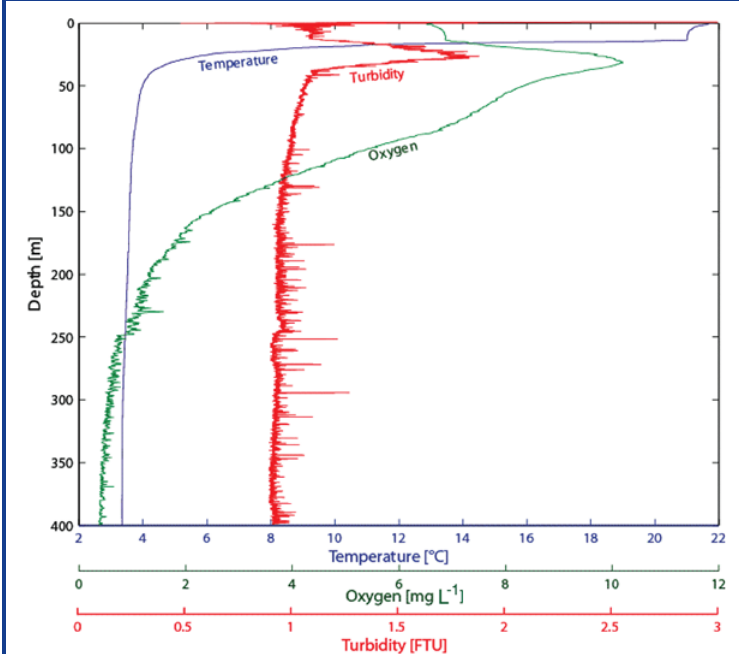
Figure 5. Temperature, turbidity (Formazin Turbidity Units), and oxygen profiles acquired with a CTD probe at the Tatvan Basin mooring site on 28 August 2009 (from S tockhecke et al., 2012). Note that oxygen content is not calibrated, in particular at lower